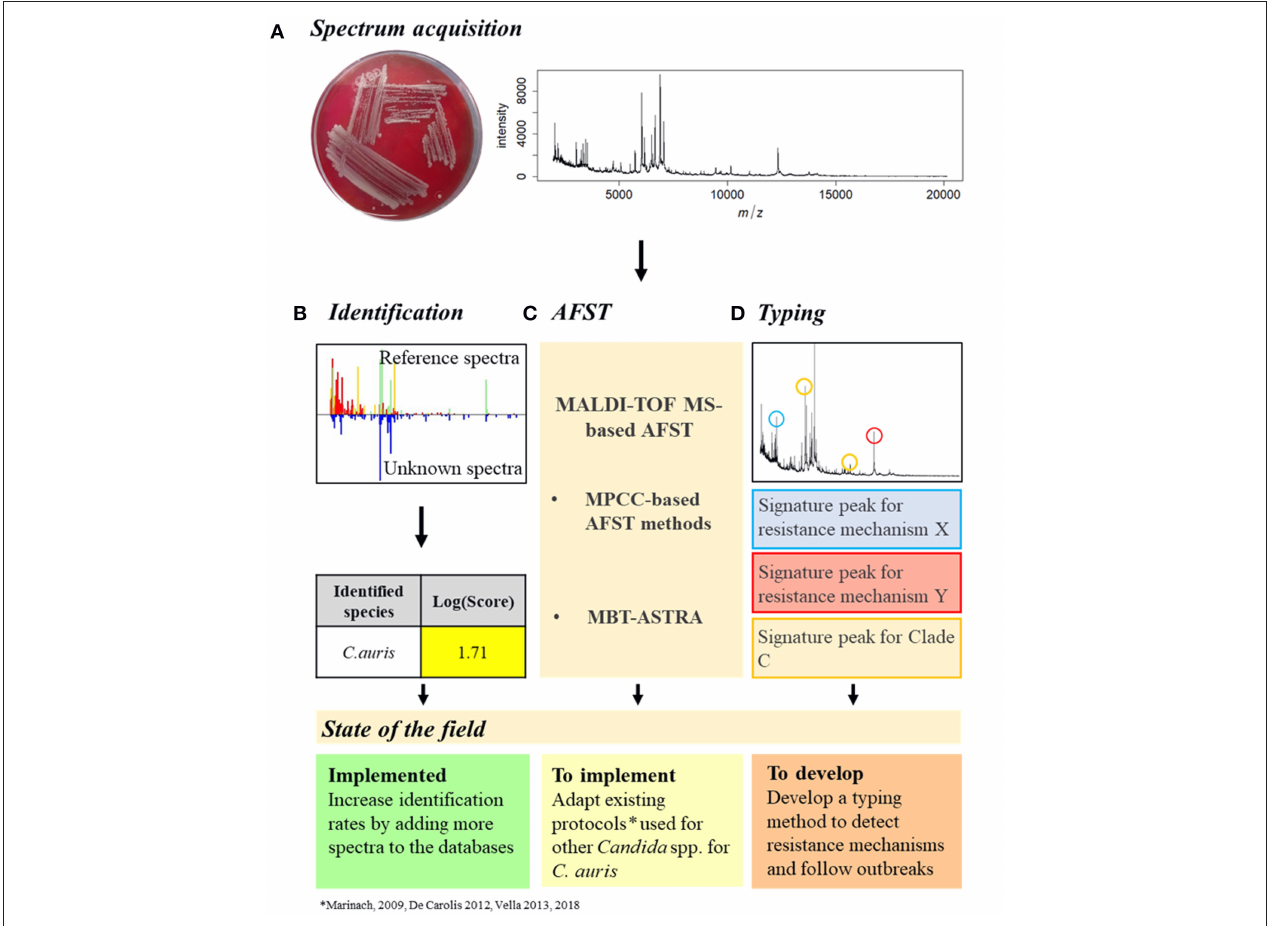
FIGURE 2 | Proposition of C. auris outbreak management with MALDI-TOF MS. (A) Spectrum acquisition. A C. auris colony (here grown on Columbia medium) is analyzed by MALDI-TOF MS to obtain a spectrum. (B) Identification. The spectrum obtained is compared to the reference spectra of the databases and an identification Log(Score) is calculated. For fungal species, a proposed identification is accepted if the Log(Score) is equal or higher than 1.7. C. auris identification with MALDI-TOF MS is already implemented but needs improvements. (C) AFST. Spectra obtained at different antifungal concentrations need to be compared to determine the MPCC. From there, once the EUCAST and/or CLSI breakpoints have been defined, the MPCC breakpoint for C. auris and an antifungal drug can be determined, allowing the AFST implementation. AFST with MALDI-TOF MS need to be adapted from existing protocols ( Marinach et al., 2009; De Carolis et al., 2012; Vella et al., 2013, 2017) to be used on C. auris. (D) Typing. Spectra of different C. auris strains originated from different clades and with different resistance mechanisms could be compared to identify signature peaks specific to different resistance mechanisms or different clades. C. auris typing with MALDI-TOF MS needs to be